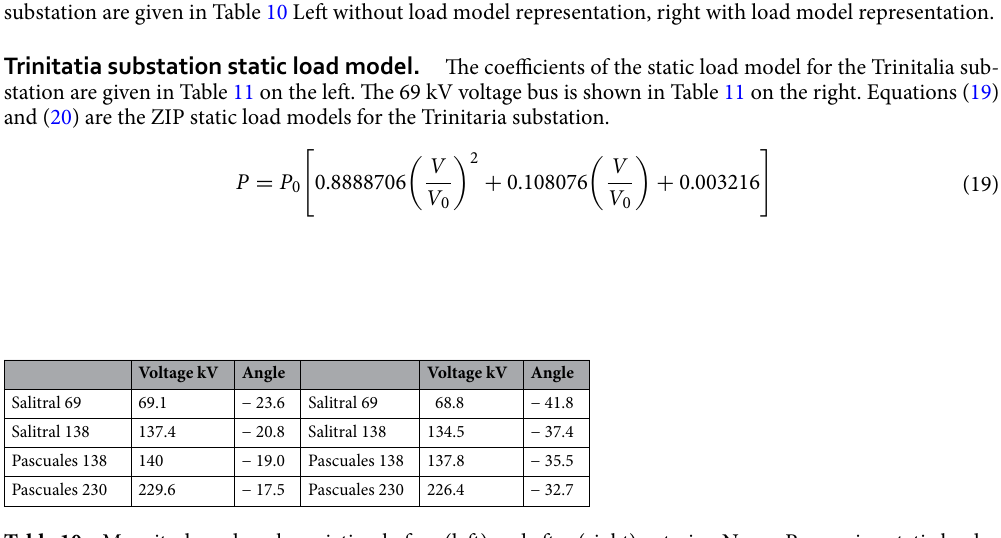
Table 10. Magnitude and angle variation before (left) and after (right) entering Nueva Prosperina static load